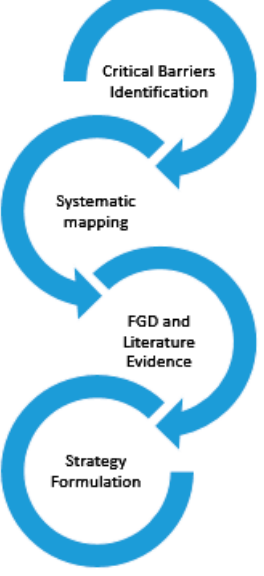
Figure 5. Illustration of strategy formulation steps.